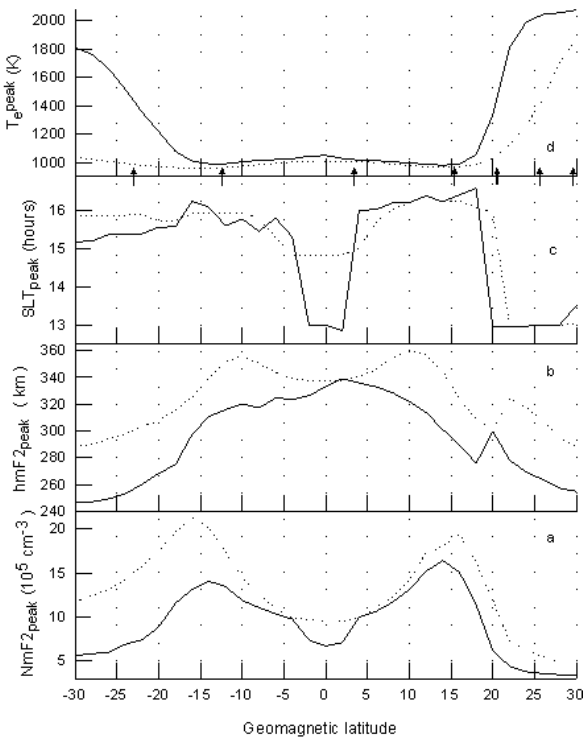
Fig. 19. The latitude dependence of the afternoon electron tem- perature peak (panel (d)), T peak e , the time of the evening electron temperature peak appearance (panel (c)), SLT peak , the value of the F 2 peak layer density at SLT peak (panel (a)), NmF 2 peak , and the F 2 peak layer altitude at SLT peak (panel (b)), hmF 2 peak , on 25 August 1987. The results shown by the solid lines were calcu- lated by the model with the corrected zonal electric field given by crosses in Fig. 1, the corrected HWW90 wind, and the corrected NRLMSISE-00 neutral temperature and densities. The dotted lines show the results produced by the model with the same value of the zonal electric field as for the solid lines, zero neutral wind, and the NRLMSISE-00 neutral temperature and densities with the same corrections as for the solid lines. Arrows at the top mark the locations of the Darwin, Vanimo, Manila, Okinawa, Yamagawa, Kokubunji, and Akita sounders at − 23.0 ◦ , − 12.4 ◦ , 3.4 ◦ , 15.4 ◦ , 29.6 ◦ , 20.5 ◦ , 25.6 ◦ , and 29.6 ◦ geomagnetic latitudes,